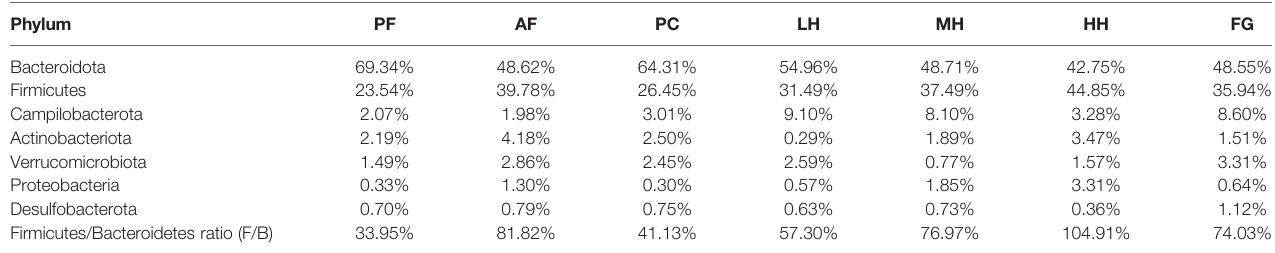
TABLE 2 | The composition table of dominant species in each group of mouse intestinal fl ora phylum level. Phylum PF AF PC LH MH HH FG